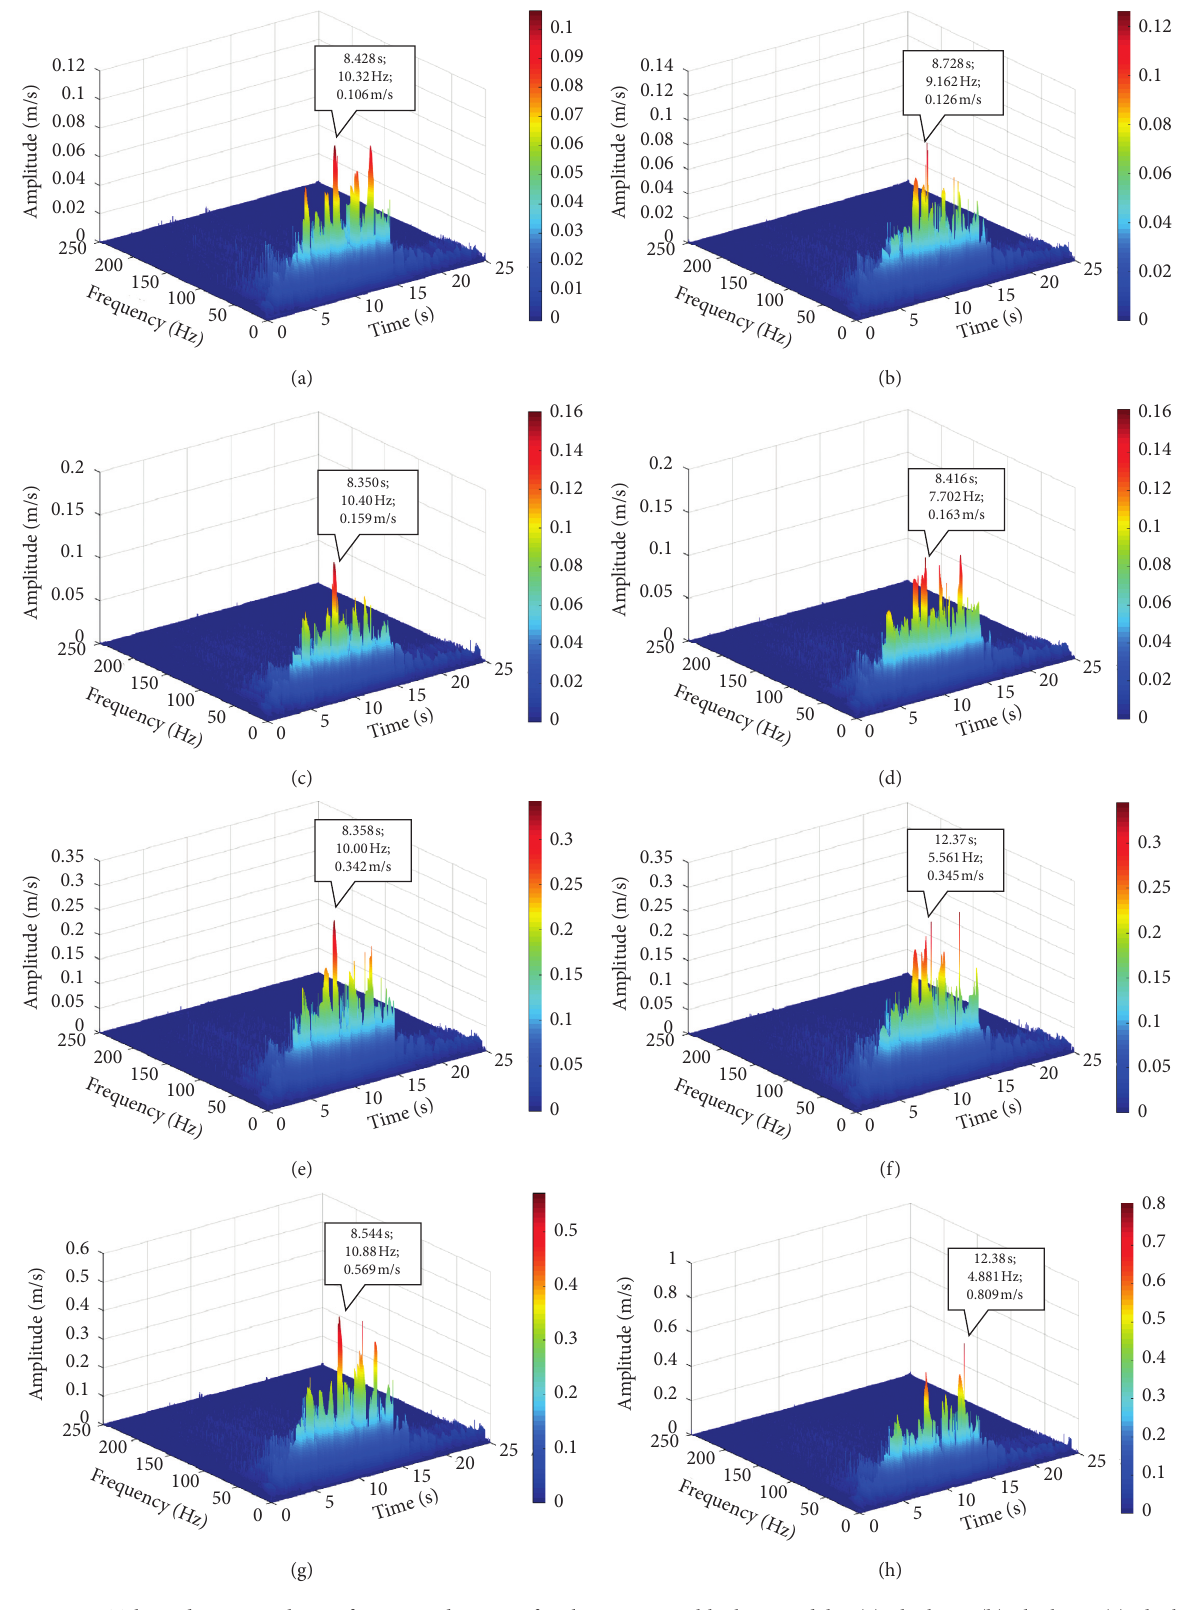
Figure 15: HHTthree-dimensional time-frequency diagram of each monitoring block in Model 1. (a) Block A1. (b) Block A2. (c) Block A3. (d) Block A4. (e) Block B1. (f) Block B2. (g) Block B3. (h) Block